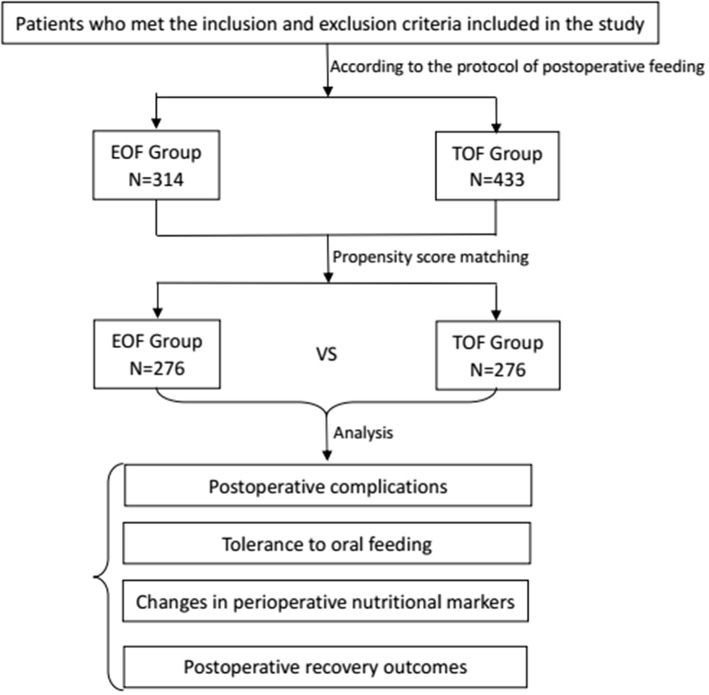
Flow chart depicting the patient selection, propensity score matching, and postoperative variables used for analysis (EOF, early oral feeding; TOF, traditional oral feeding).